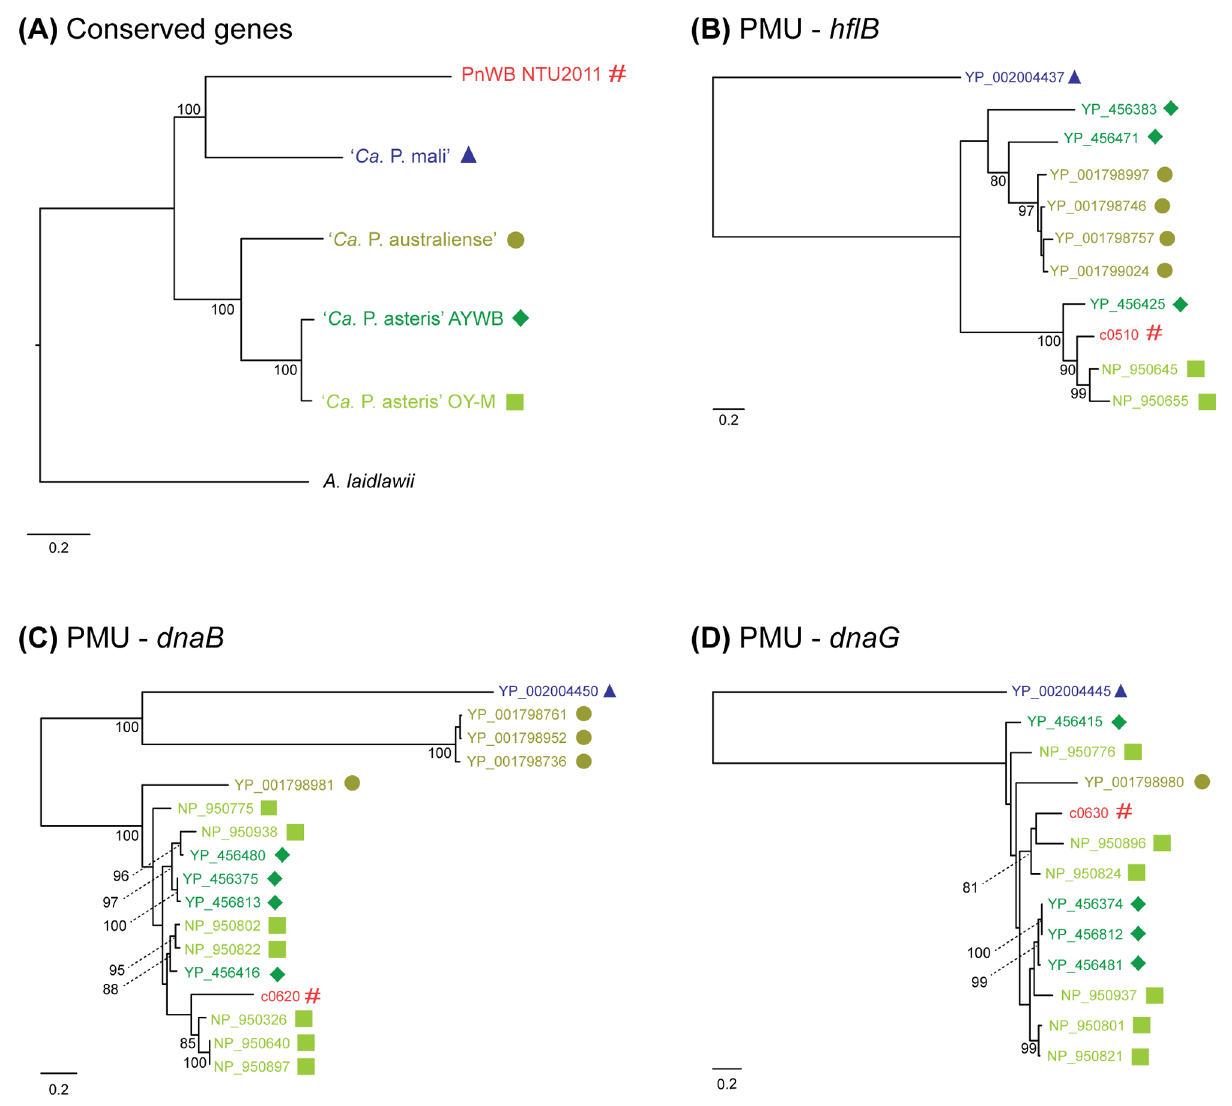
Figure 5. Molecular phylogeny of conserved and PMU-associated genes. The numbers on the internal branches indicate the percentage of bootstrap support based on 1,000 re-sampling (only values . 80% are shown). (A) The organismal phylogeny based on the concatenated alignment of 214 single-copy genes conserved among the five phytoplasma genomes and the outgroup A. laidlawii (75,565 aligned amino acid sites). The tree topology is consistent with that inferred from 16S rRNA genes (Figure 1). (B) Molecular phylogeny of PMU-associated ATP-dependent Zn protease ( hflB ; 855 aligned amino acid sites). (C) Molecular phylogeny of PMU-associated replicative DNA helicase ( dnaB ; 533 aligned amino acid sites). (D) Molecular phylogeny of PMU-associated DNA primase ( dnaG ; 614 aligned amino acid sites). Note that the outgroup is not included in panels (B)-(D) because no PMU was found in the A. laidlawii genome.